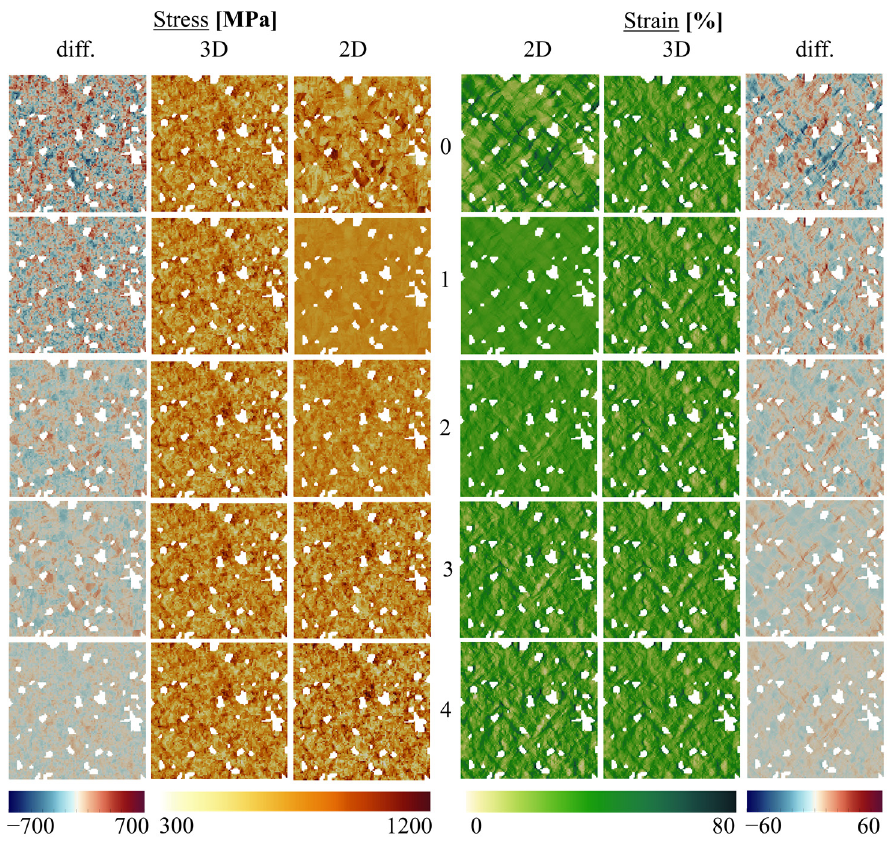
Figure 7. Local von Mises stress and strain distribution for the ferrite phase of case 1 with different iterative steps. The extreme left and right column indicate the 2D and 3D local stress and strain distribution differences,